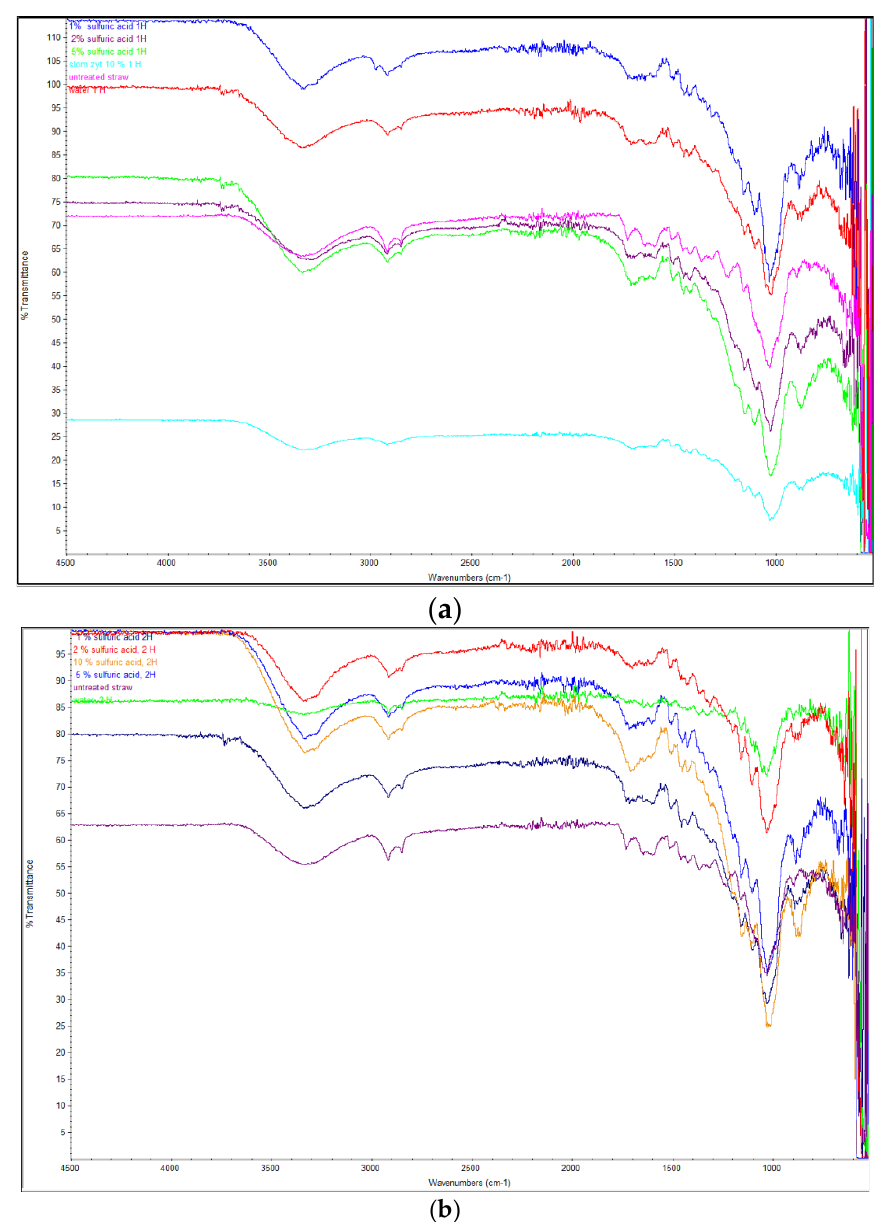
Figure 1. FTIR spectra of untreated and pretreated rye straw by different sulfuric acid concentration at 121 °C, 1 h ( a ) and at 121 °C, 2 h ( b ).